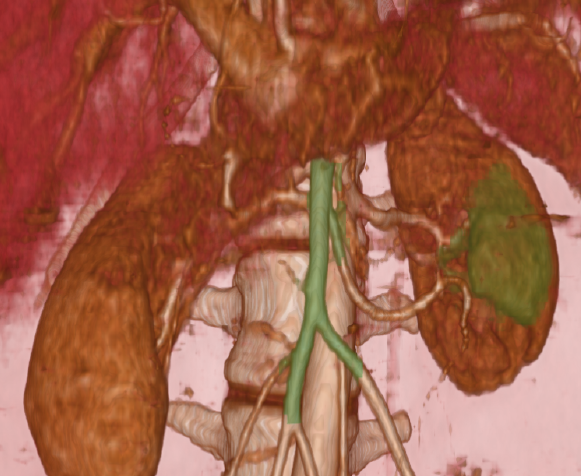
Figure 5. Multiple handles can be selected at the same time, and they can be controlled